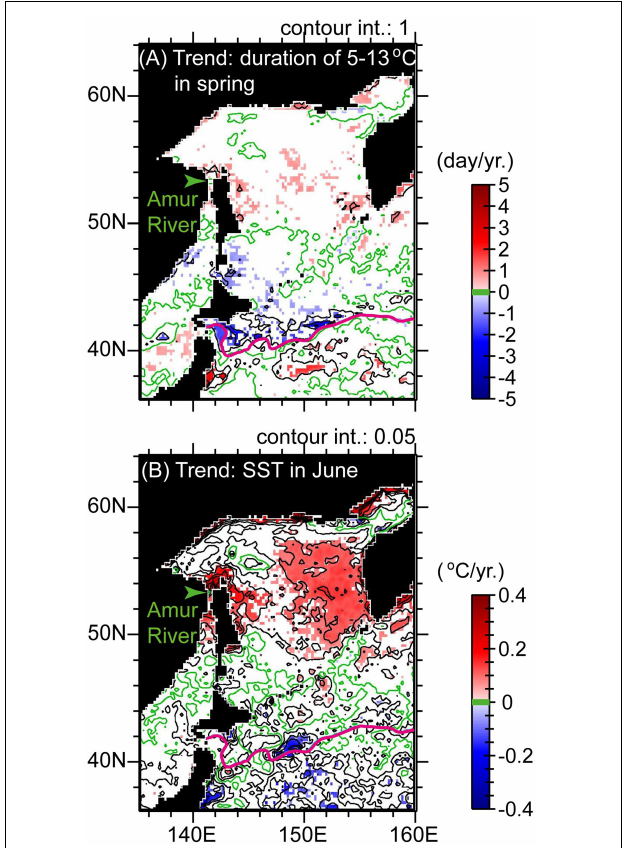
FIGURE 9 | (A) Trends in 2000–2014 for the duration of periods with SSTs of 5–13 ◦ C in spring. (B) Trends of SSTs in June. Display style is the same as in Figure 4